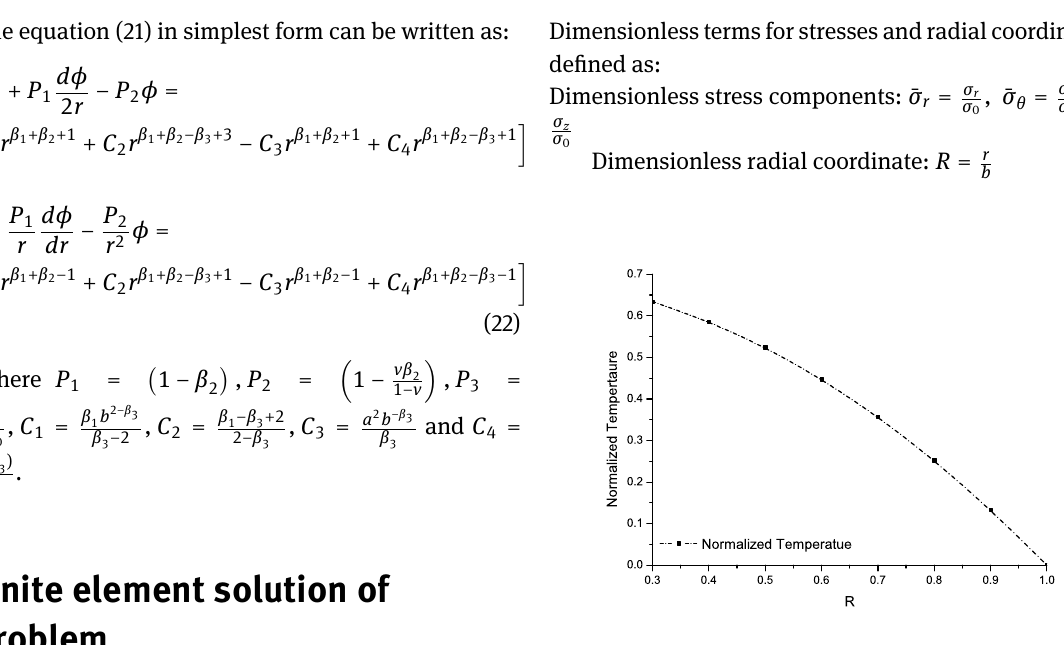
Figure 1: Represents normalized temperature and dimensionless radial coordinate